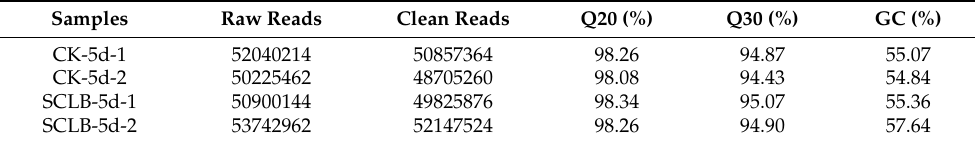
Table 1. Overview of the sequence assembly after Illumina sequencing.